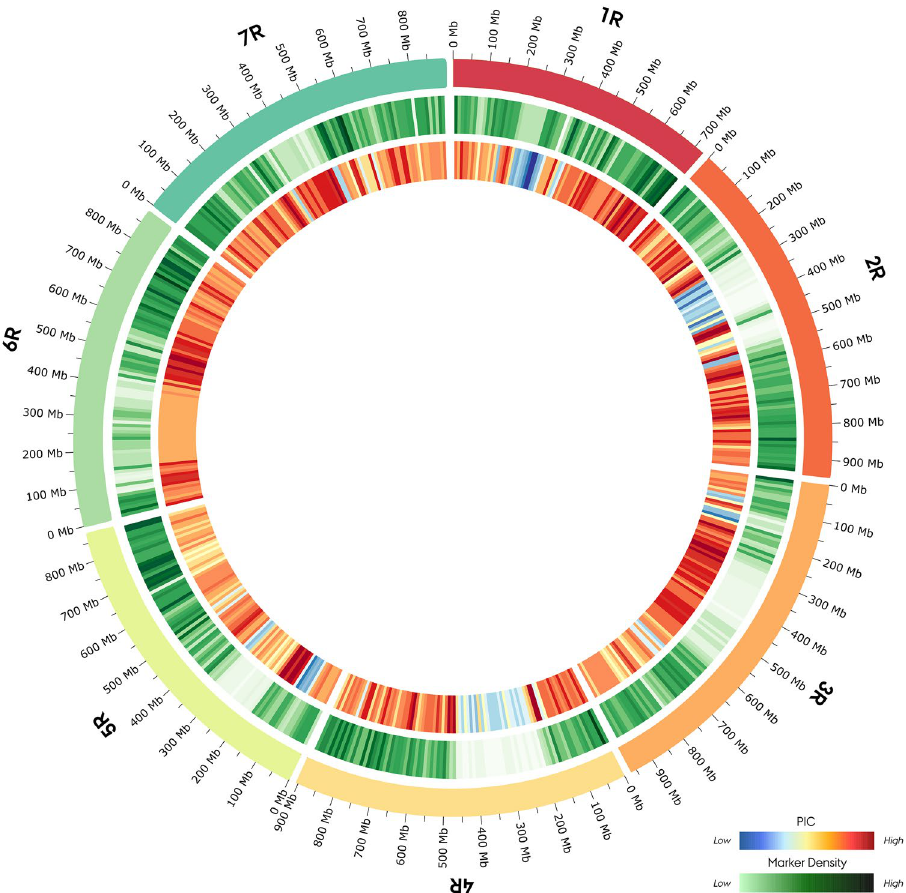
Figure 1. Distribution of 244,463 informative 600 K SNP array markers in 180 Nordic Seed hybrid rye ( Secale cereale L.) breeding lines along the ‘Lo7’ reference genome in 10 mb bins. The outer track depicts the marker density per bin. The inner track depicts the polymorphism-information content (PIC) per bin.